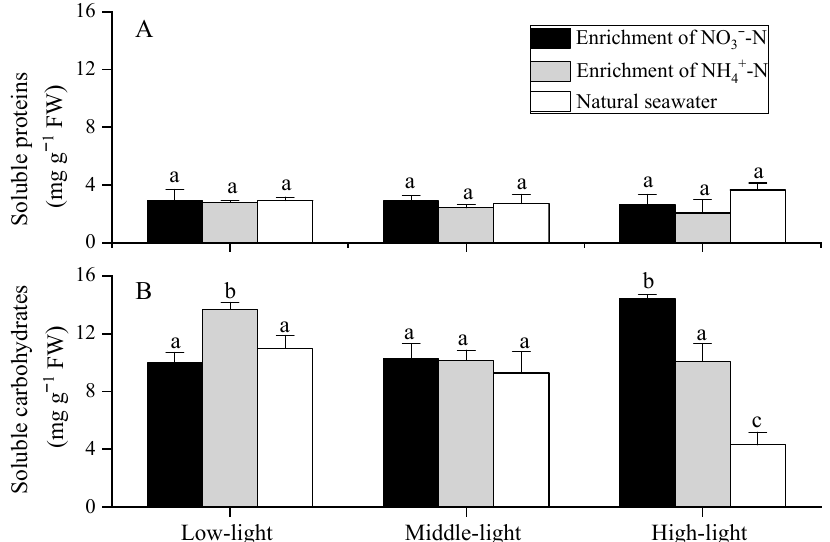
Figure 6. The contents of soluble protein ( A ) and carbohydrates ( B ) of S. horneri after being grown at different light and N conditions for 10 days. Data are reported as means ± SD (n = 3). Different letters above the error bars indicate significant differences between treatments ( P < 0.05).